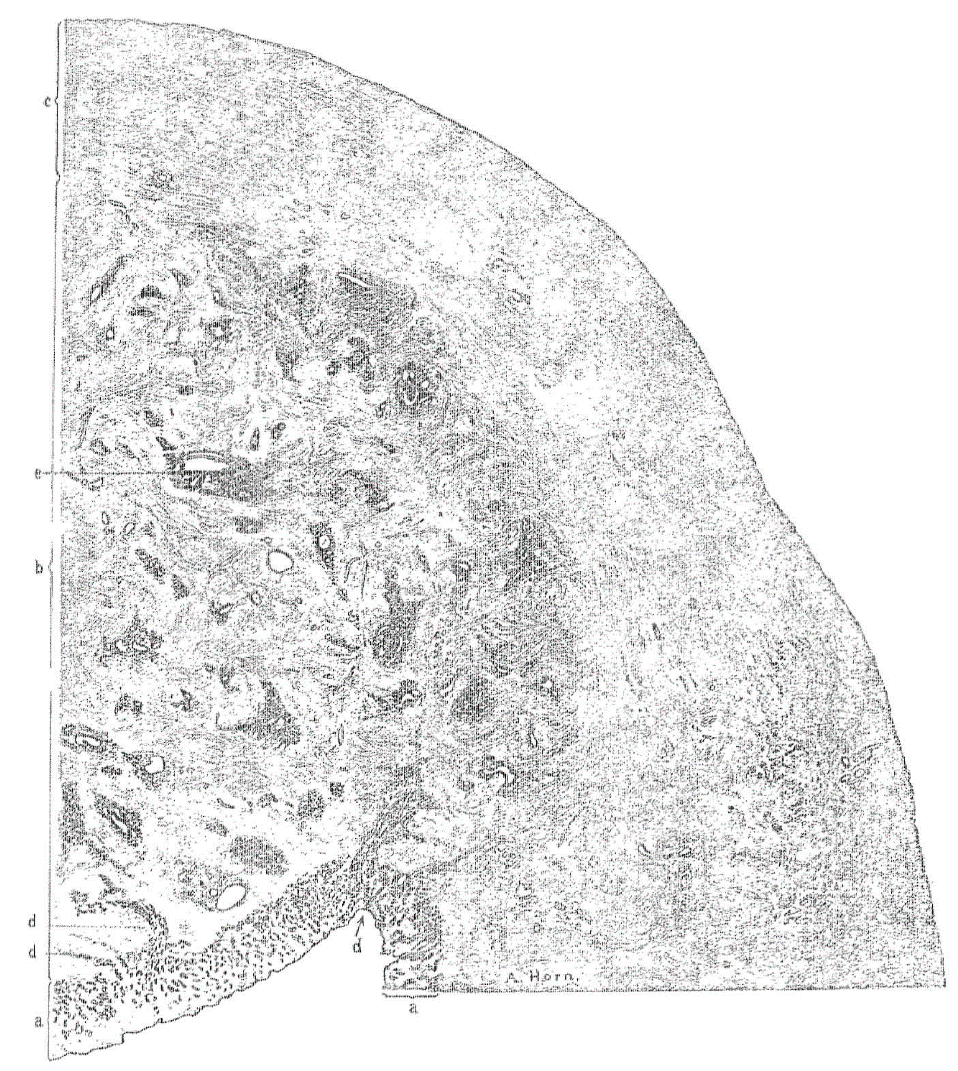
Figure 2. Section of the upper half of the posterior wall of the uterus with adenomyosis. The wall has three distinct zones: (a) Inner mucosa, (b) region with adenomyosis, (c) outer normal muscle tissue. The gland at (d) extends directly into the muscle and at (e) the gland is retracted from the surrounding stroma. The illustration demonstrates the meticulous work by Thomas Cullen (1908).